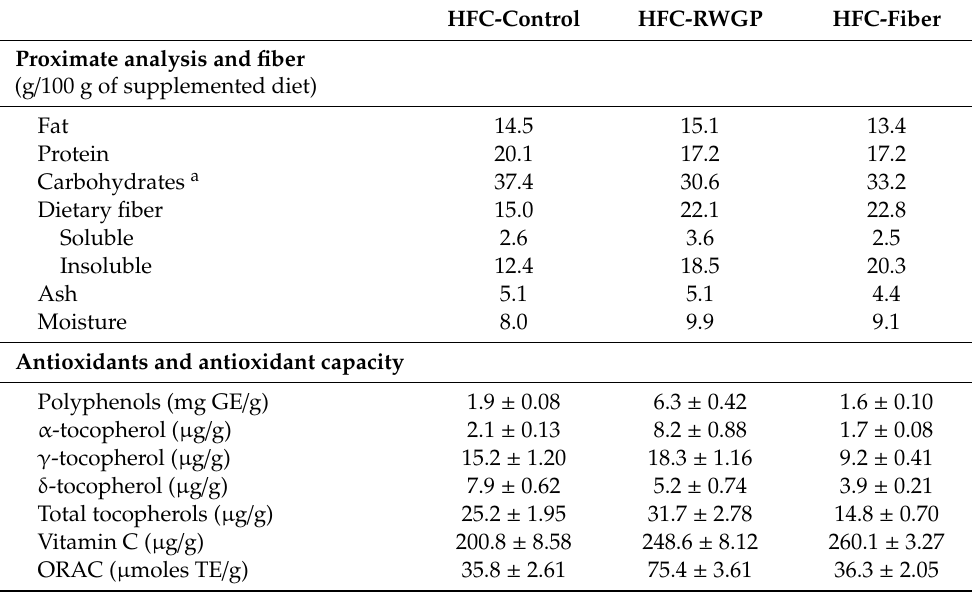
Table 1. Nutritional composition of atherogenic diets supplemented with 20% chow (high fat, high cholesterol, and cholic acid (HFC)-Control), 20% red wine grape pomace (RWGP)